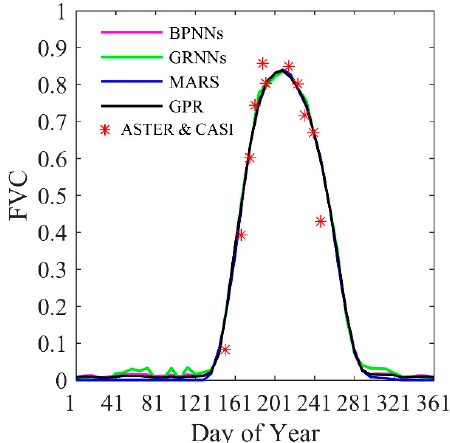
Figure 9. FVC temporal profiles derived from the VIIRS data using the four machine learning methods and the ASTER/CASI FVC data from Heihe in 2012.